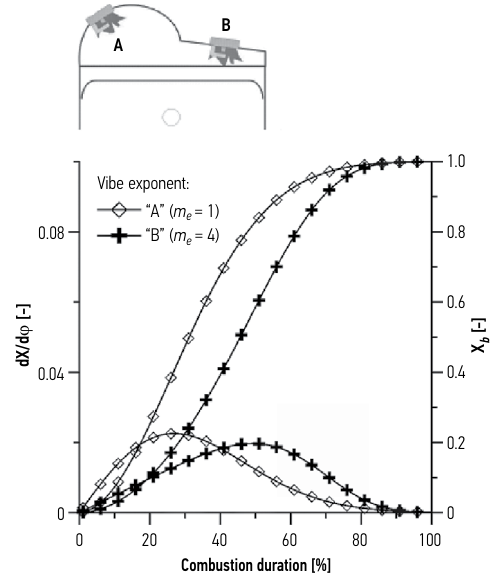
Fig. 4. Burned mass fraction and burn rate in the function of combustion duration at two different ignition points A and B ( source : own calculations)